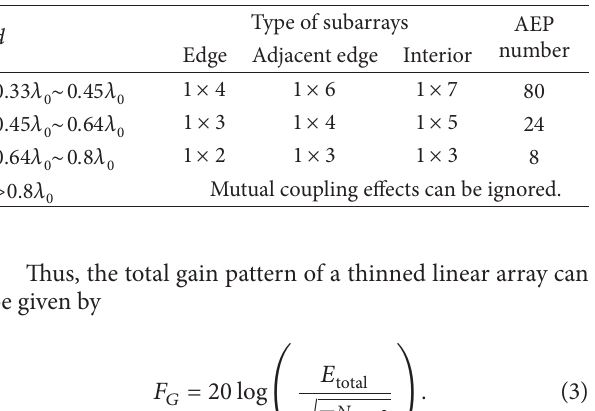
Table 1: Types of subarrays and their AEP